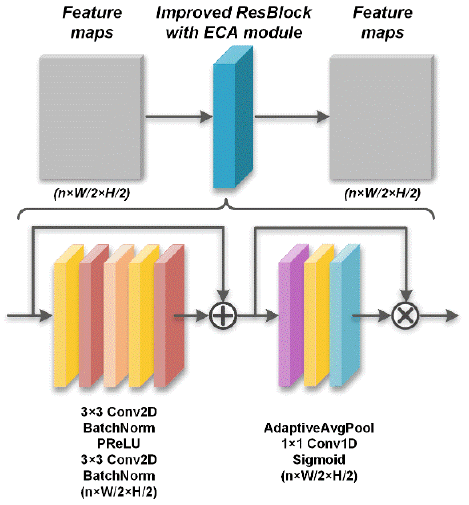
Figure 3. Improved ResBlock with ECA module framework.